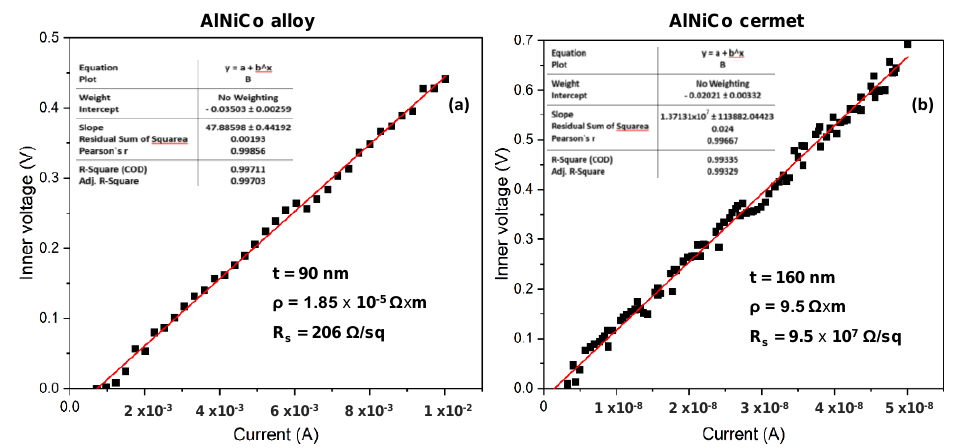
Figure 5. Sheet resistance of ( a ) the initial CoNiAl and ( b ) the annealed sample.